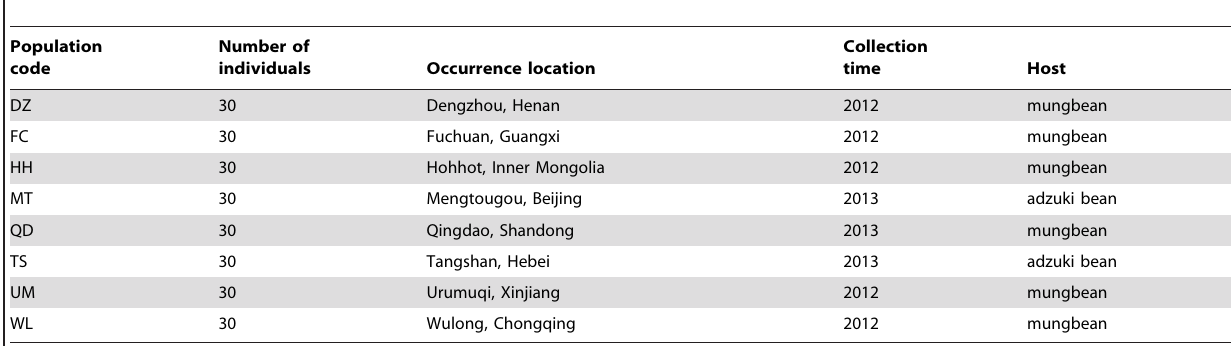
Table 1. The information of 8 Callosobruchus chinensis genotypes used in polymorphism test of SSR markers.